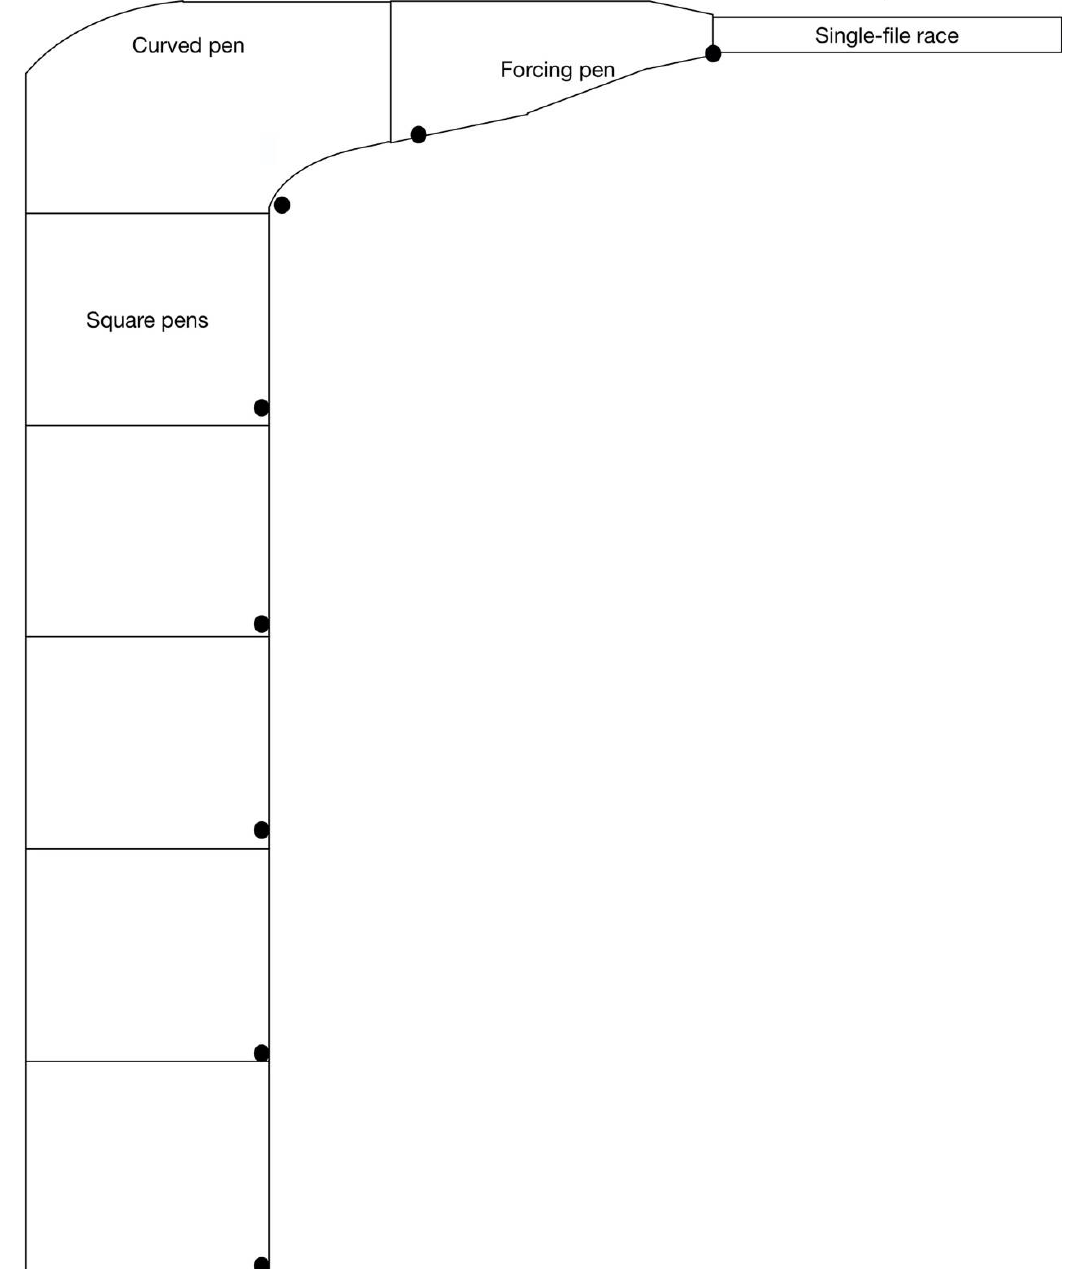
Figure 1. Diagram of the abattoir layout including camera locations, marked with black circles. Cameras were arranged in order from Camera 1 in the square pen at the bottom of the diagram through to Camera 6 at the curved pen, Camera 7 at the forcing pen, and Camera 8 at the single-file race.